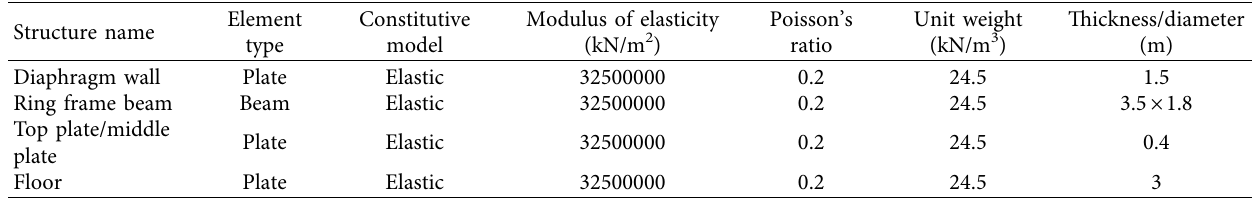
Table 3: Details of construction